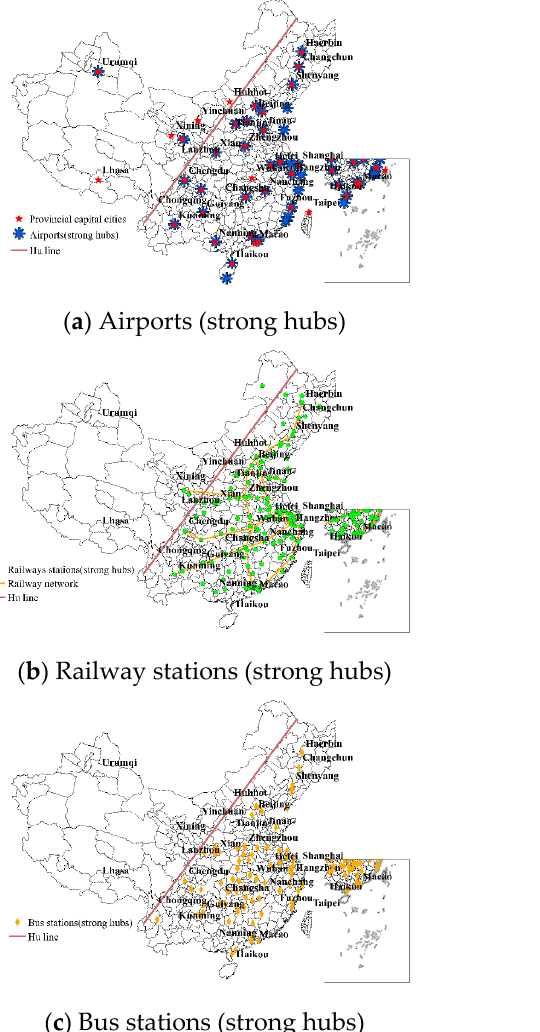
Figure 3. Distribution of different levels of transportation facilities. The strong hubs were located mainly in the eastern region and roughly bordered by the Hu Huanyong line (i.e., a comparison line proposed by geographer Hu Huanyong to classify the population density of the country).The weak hubs were scattered in small and medium-sized cities in various provinces. Combined with the spatial distribution